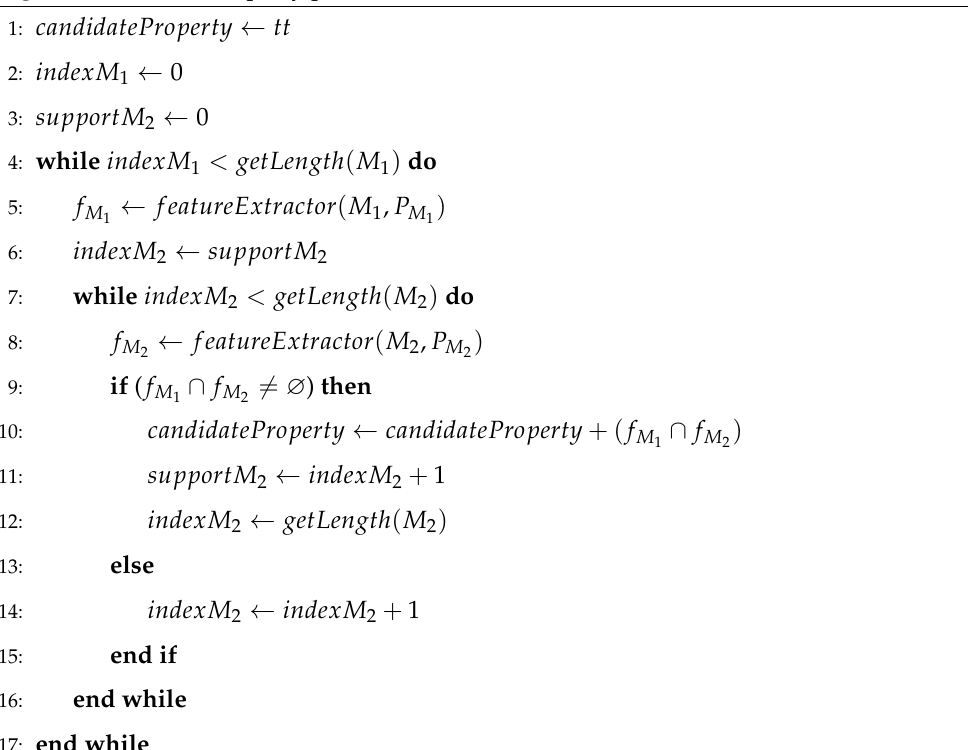
Algorithm 1 Build_Property pseudo